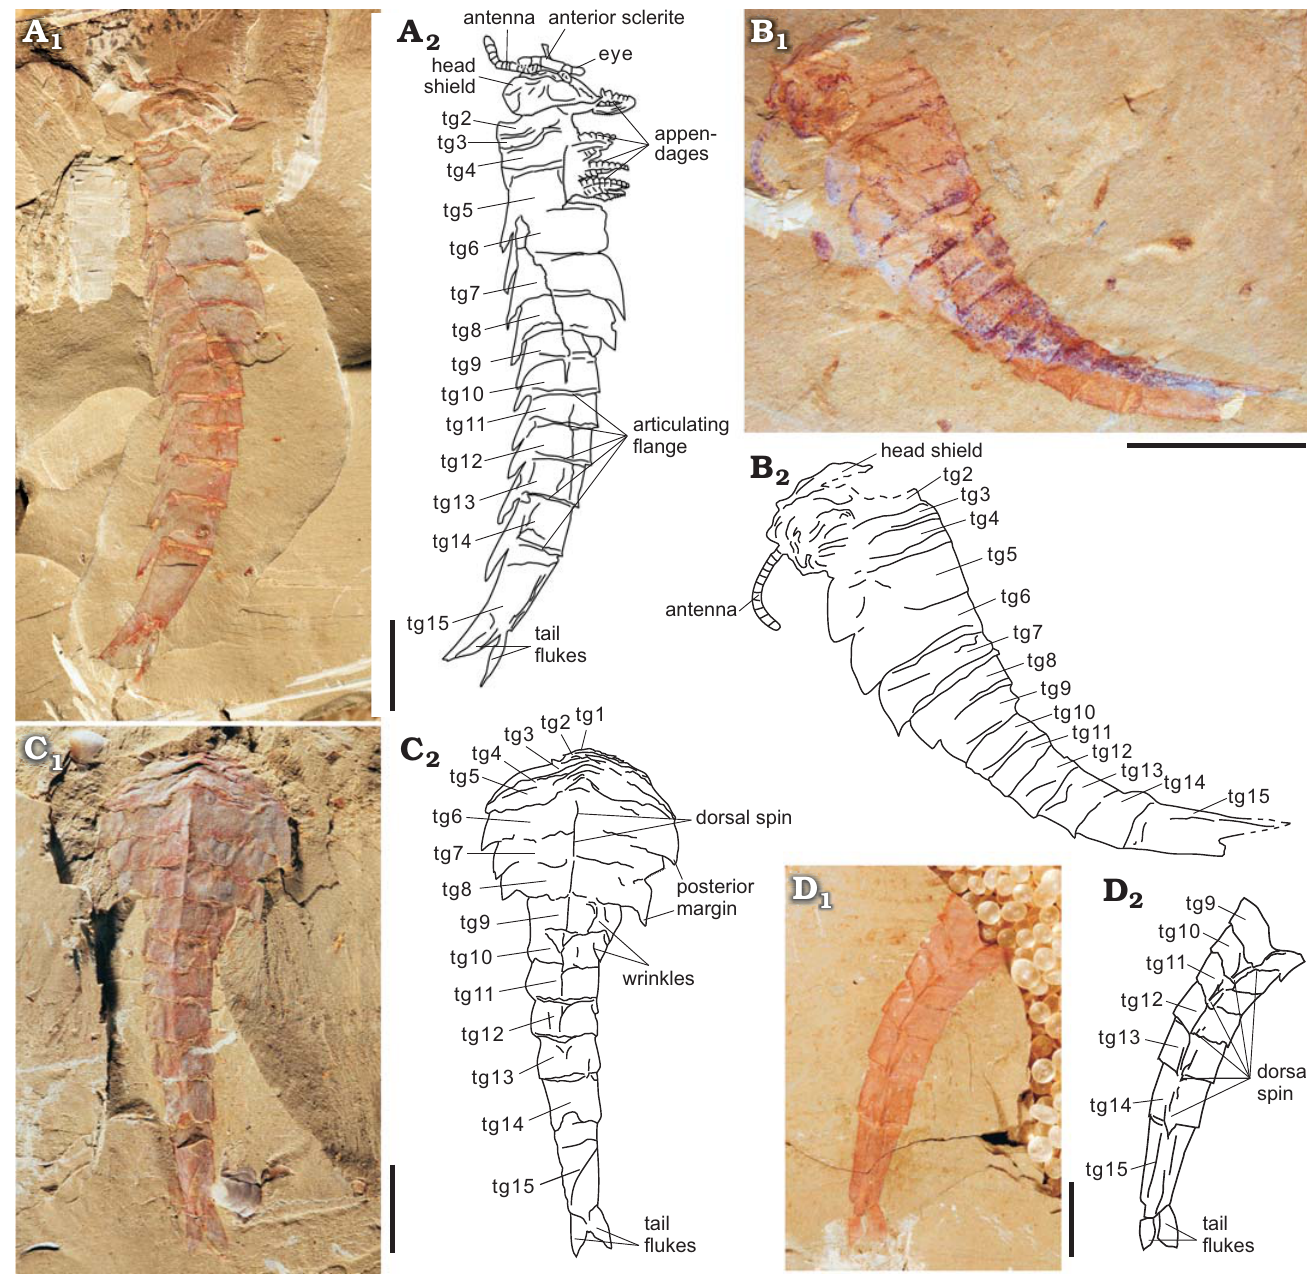
Fig. 1. Fuxianhuiid euarthropod Guangweicaris spinatus Luo, Fu, and Hu, 2007 from Guanshan Biota, Cambrian Series 2, Stage 4, Yunnan, China. A . ELI-LBSG-0046A in lateral view, showing the whole animal, including several important morphological characters of Guangweicaris : the rotated ocular segment, the pair of clavate antennules (although the right one in poorly preserved), the cephalic shield, the cephalic-appendages, the thorax, the ab- domen, and the tail flukes. B . ELI-LBSG0006B in lateral view, showing the whole animal. C . ELI-LBSG-0047 in dorsal-ventral view, showing the typical Guangweicaris thorax, abdomen, and a pair of tail flukes. D . ELI-XLCG-022B in dorsal-ventral view, showing the typical Guangweicaris abdomen and the two tail flukes. Abbreviations: tg, tergite (tg1–tg3, anterior reduced segments; tg4–tg8, thoracic tergites; tg9–tg15, abdominal tergites). A –D , explanatory drawings. Scale bars 10 graphs; A 2 2